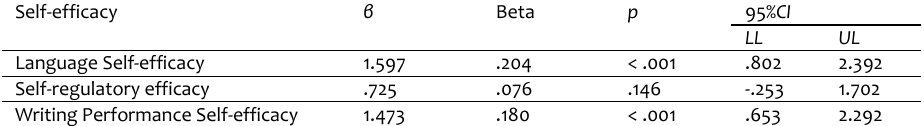
Table 7. Multiple Regression Results of Self-efficacy on Writing Test Scores (N =